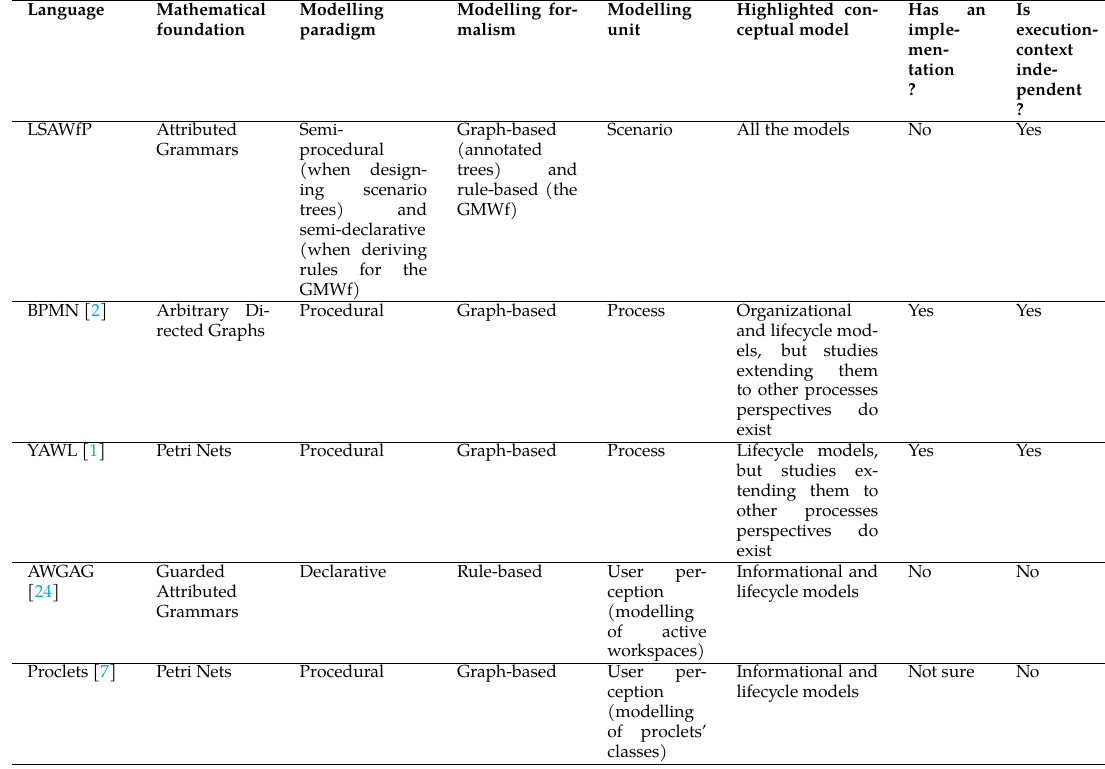
Table 2: A comparison of LSAWfP with other workflow